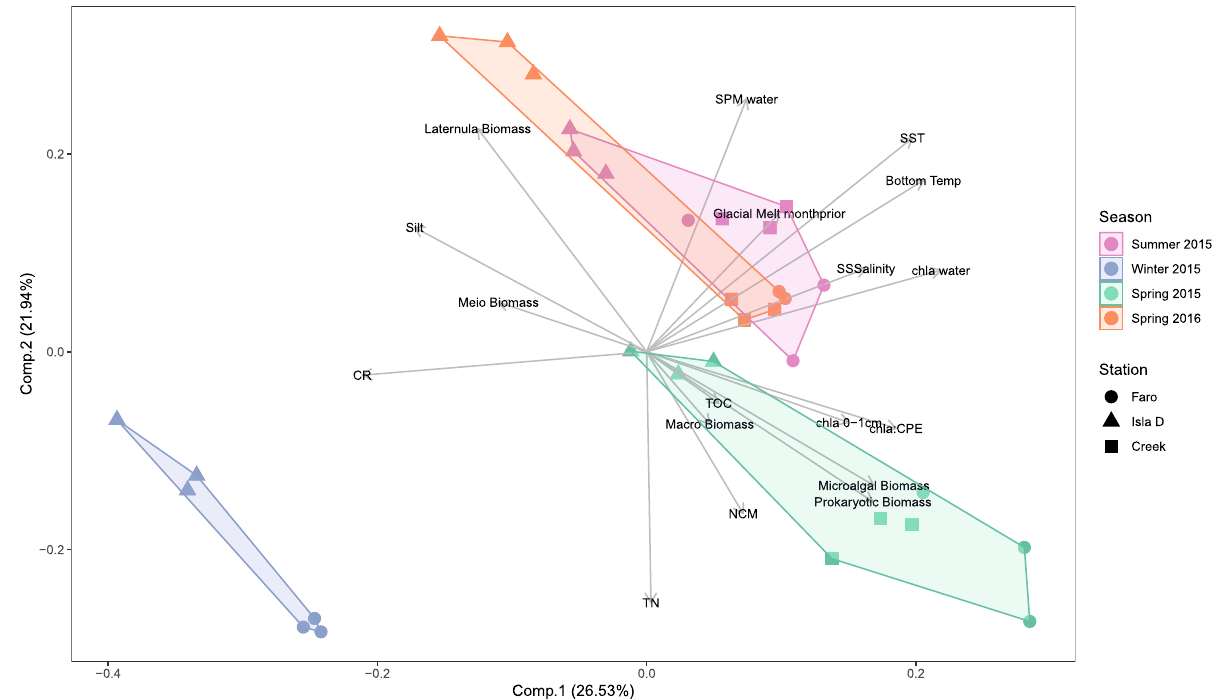
Fig. 4 PCA of the water column and benthic parameters. Benthic parameters include environmental, biotic (averaging macrofauna and Laternula elliptica data over summer and spring 2015 because of lacking winter data) and benthic carbon balance parameters. Note the temporal clustering and the separate cloud of samples close to the glacier front (Isla D; triangles). Source data can be found in Supplementary Dataset